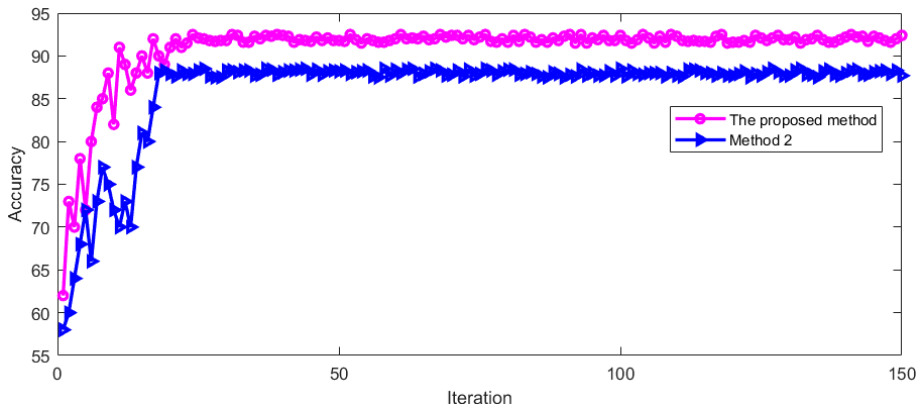
Figure 19. The recognition accuracy of two methods in the test set.